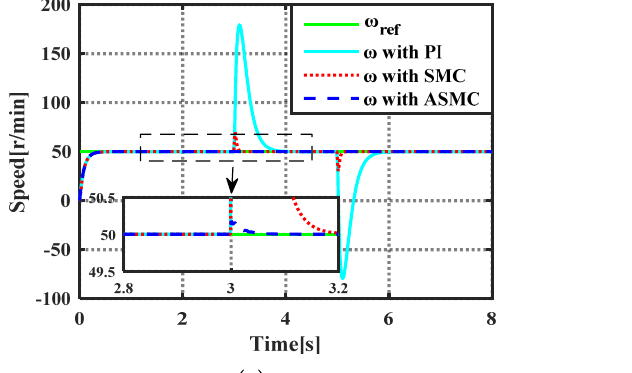
Figure 5. Simulation results of dynamic response when parameters mismatch. ( a ) PI controller; ( b ) SMC method; ( c ) ASMC method; ( d ) the estimated disturbances when parameters mismatch.